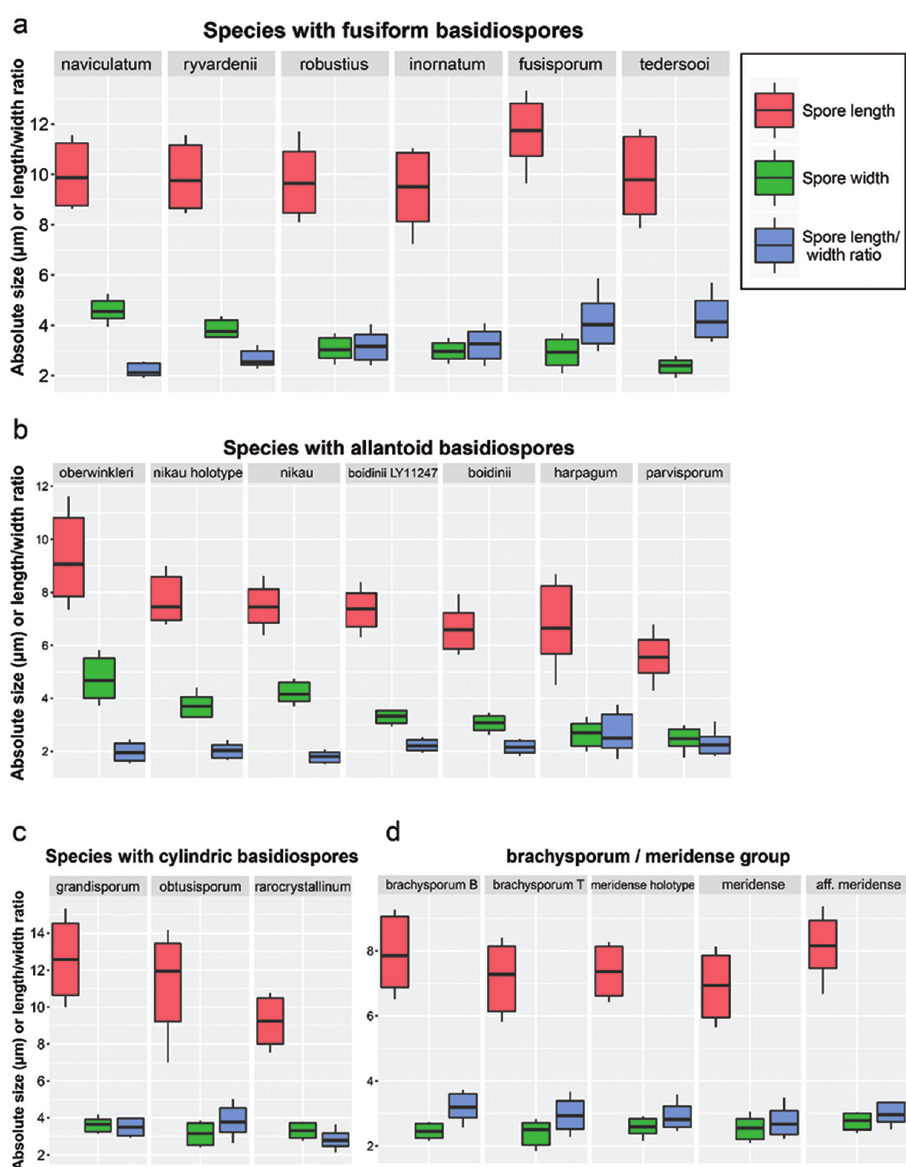
Figure 11. Basidiospore size range in the short-spored species of Subulicystidium . Only measurements from sequenced or important historical collections were included in calculations (in total 67 specimens, 2840 basidiospores). Boxes (with median inside) delimit the range between 5% and 95% data quantiles, while the whiskers show minimum and maximum values without considering outliers (see Materials and Methods for details on excluding outliers). If more than one sequenced specimen was available for species, raw measurements without outliers were pooled to calculate basidiospore size range of the species. In S. brachysporum , the capital “B” following epithet means morphological species concept following Boidin and Gilles (1988), while “T” means the species as described by Talbot